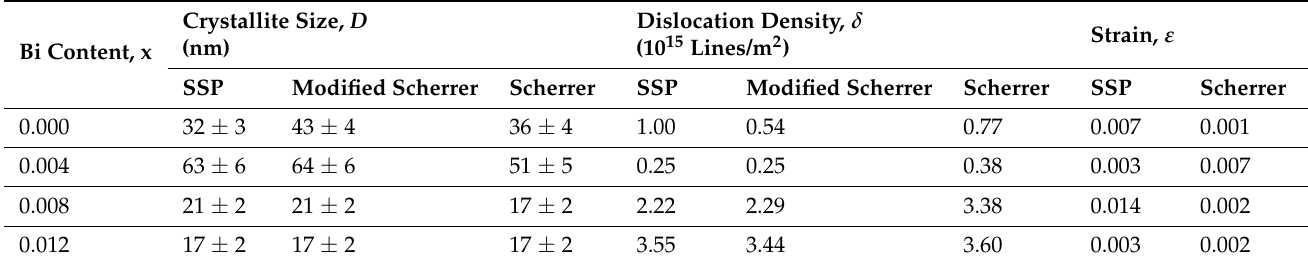
Table 2. Crystallite size, dislocation density, and strain of the sample calculated from Scherrer, modified Scherrer method, and size strain